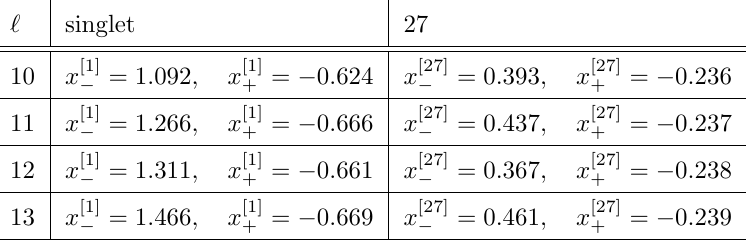
L at the poles of the Pad(cid:19)e Approximants in (cid:25)